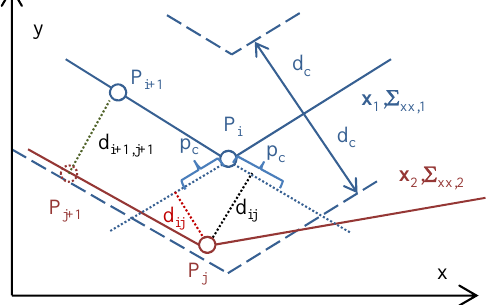
Figure 2 . Buffer (dashed blue lines) of valid areas for